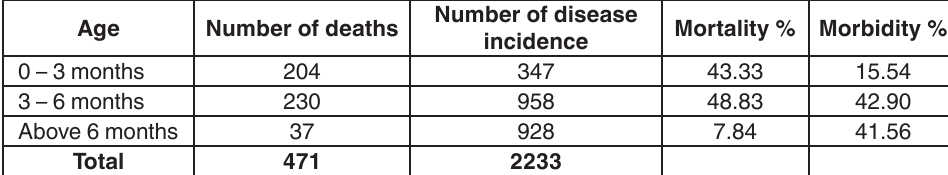
table 6: Percent mortality and morbidity in males and females sex Number of deaths Number of disease